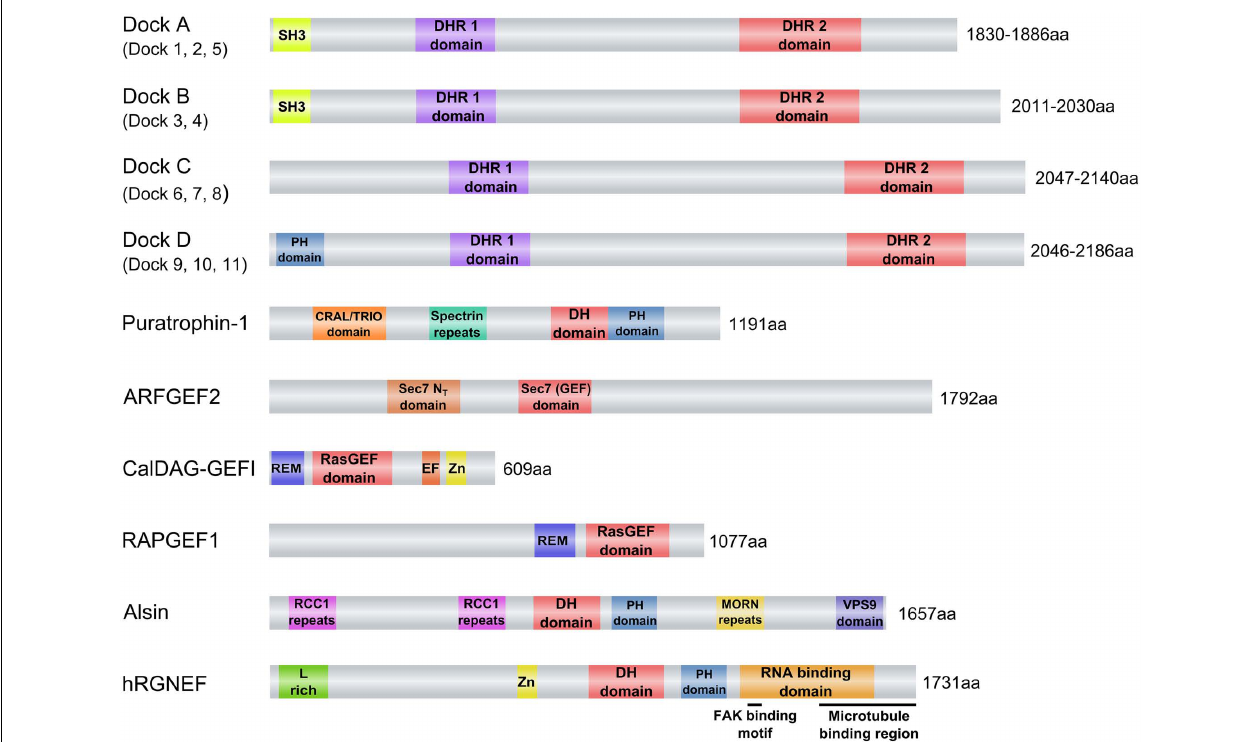
exchange factor; L-rich, Leucine-rich region; MORN repeats, Membrane Occupation and Recognition Nexus repeats; PH domain, Pleckstrin homology domain; RAPGEF1, Ras-related protein GEF1; RasGEF, Guanine nucleotide exchange factor for Ras-like small GTPases; RCC1 repeats, Regulator of chromosome condensation repeats; REM, Ras exchanger motif; Sec7, Domain named after the S. cerevisiae SEC7 gene product; Sec 7 N T , Amino-terminal Sec 7 domain; SH3, Src Homology 3 domain; Spectrin repeats, Spectrin-like repeats; Zn, cysteine-rich zinc binding domain. The schematics were based in the information obtained from the “conserved domain” search tool from NCBI (http://www.ncbi.nlm.nih.gov/